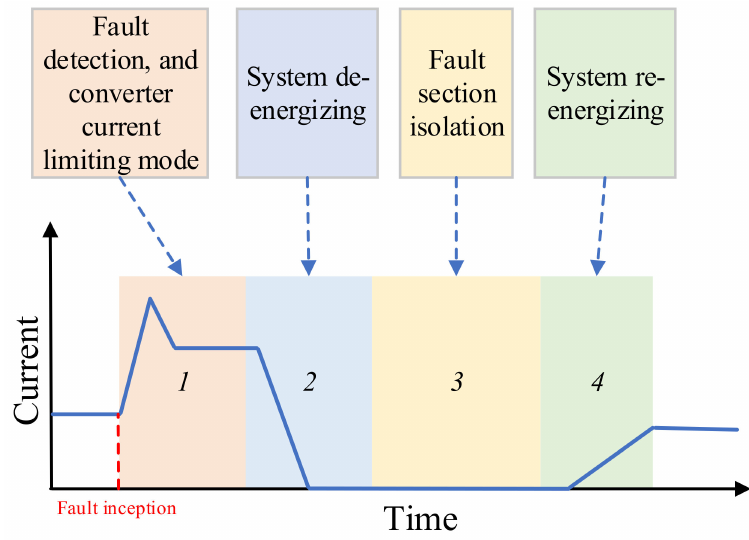
Figure 10. Converter control steps for fault mitigation.